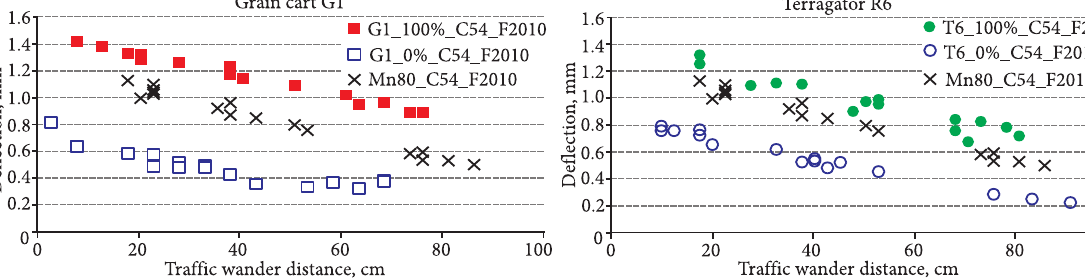
Fig. 7. Effect of vehicle type and weight on vertical deflections at the middle of the PCC slab near mid-slab